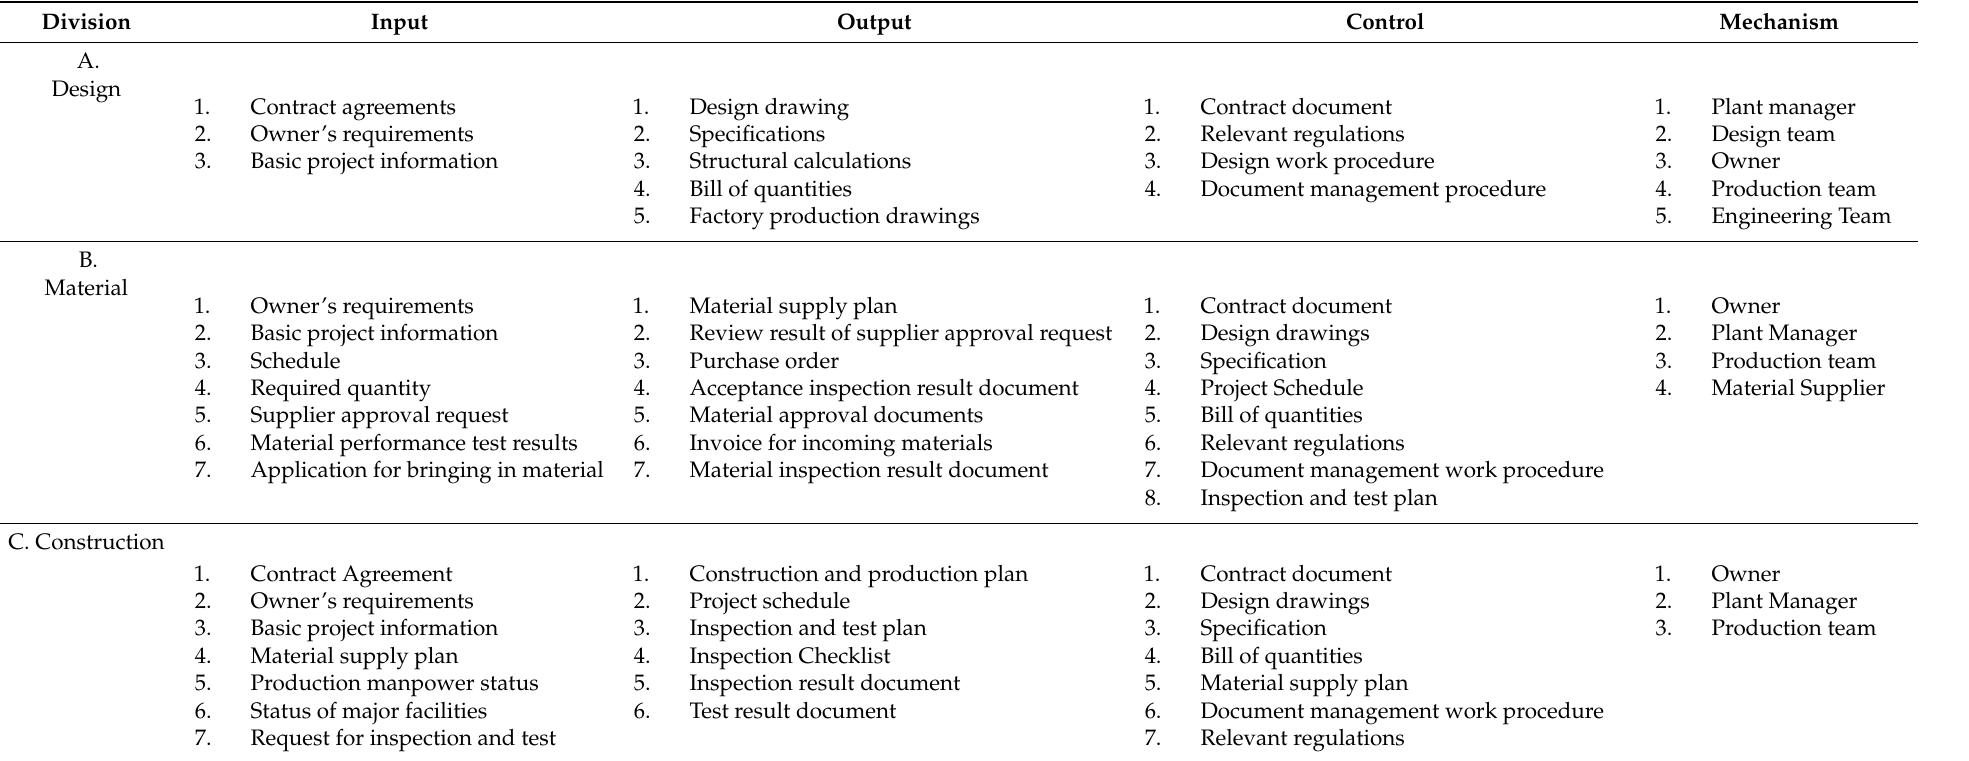
Table 1. Quality information generated during each production